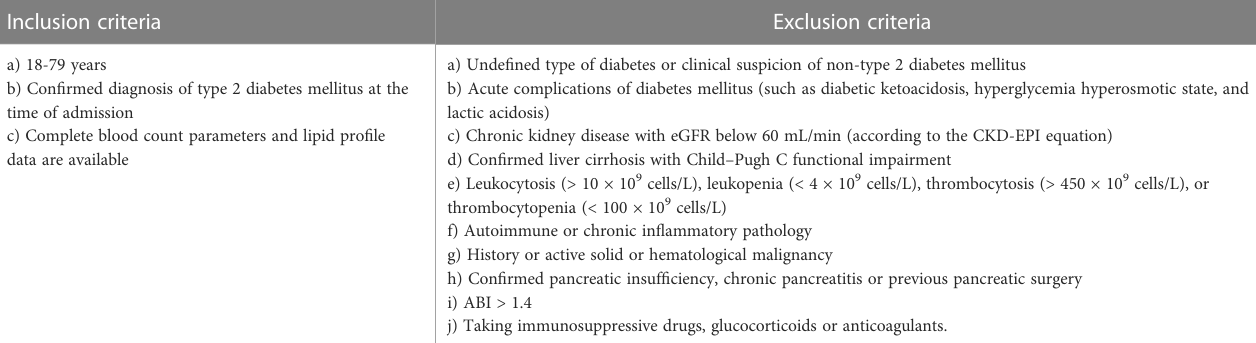
TABLE 1 Inclusion and exclusion